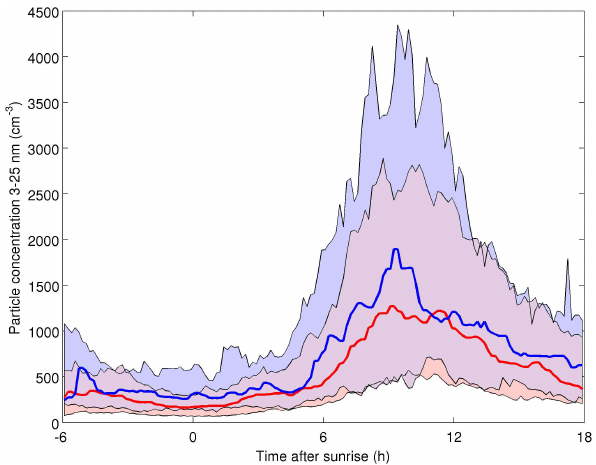
Fig. 5. Electrically charged particle concentration below the acti- vation size as a function of the time spent after sunrise for (a) 0.4 to 1.8nm particles on the left and (b) 0.75 to 1.0nm particles on the right (Tammet diameter). The median concentrations for over- charged days are in red and for undercharged days, in blue. The median on non-event days are also added for comparison in black. The colored areas represent the 25th to 75th percentiles (for over- and undercharged days only). Negatively charged particles are in the upper part of the plot and the positively charged ones in the lower part of the